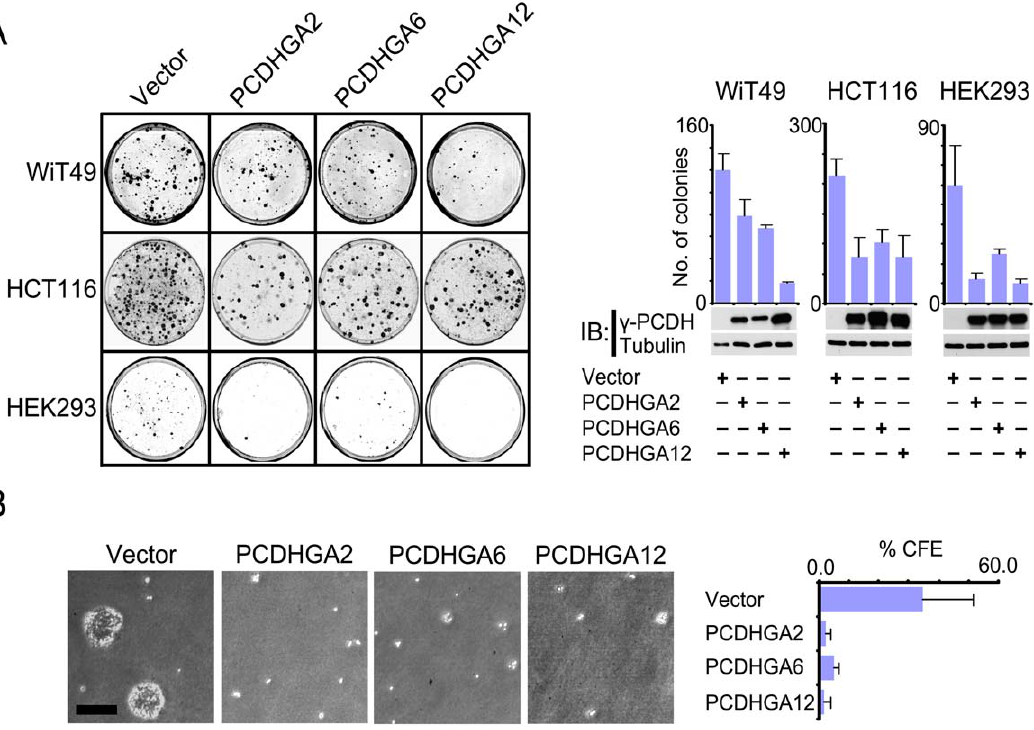
Figure 6. Growth inhibition by PCDHs. (A) Suppression of WiT49, HCT116, and HEK293 cell colony formation following ectopic expression of PCDH cDNAs. After selection and staining, plates were photographed and colony counts determined for each transfection. Representative plates (left) and mean colony counts (right) are shown, Verification of PCDH protein expression after transfection, together with tubulin as a loading control is shown below the histograms. (B) Inhibition of anchorage-independent growth of HCT116 cells by PCDHs, cells were plated in triplicate and colonies formed after 10–14 days were photographed and counted within 10 random fields. Representative fields are shown (left) together with colony forming efficiency (CFE), expressed as percentage of colonies . 50 m m diameter (right). Cell-based assays were repeated at least twice, and representative data are shown.